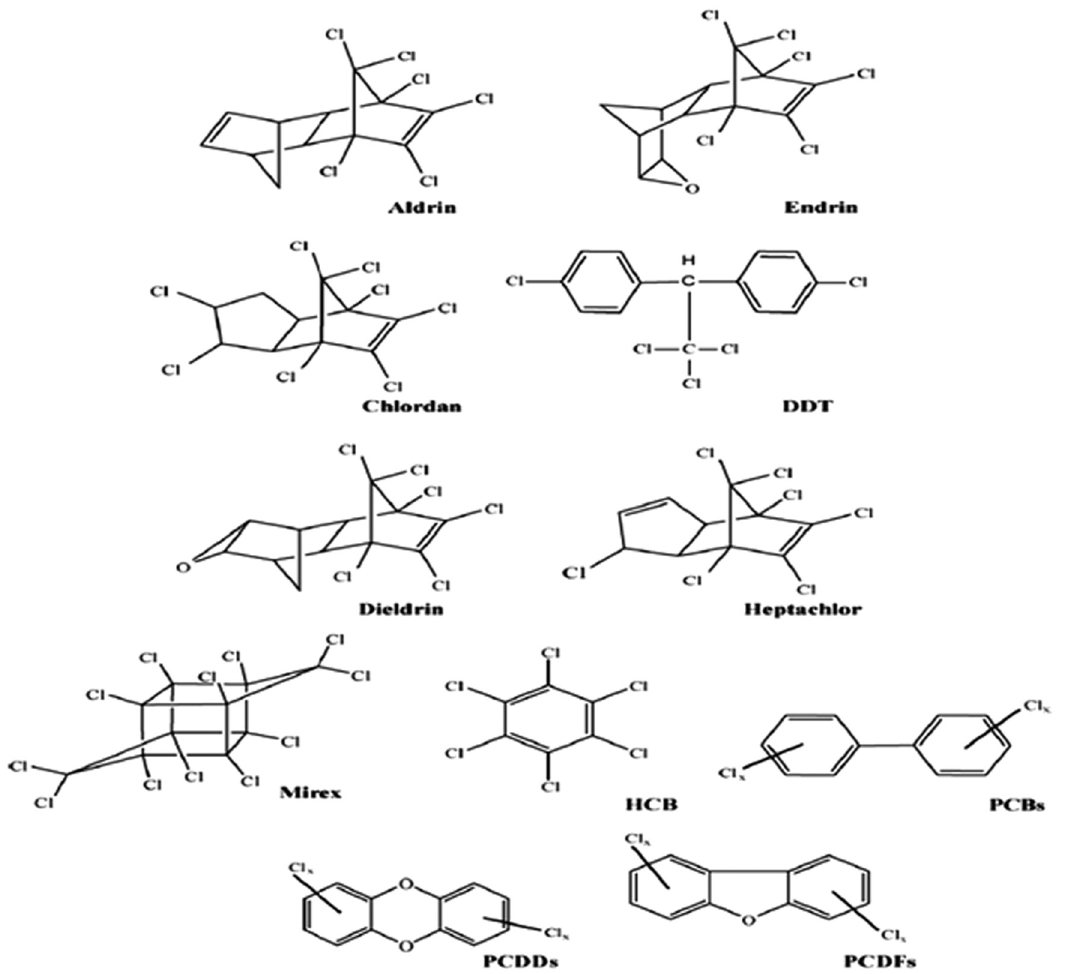
Figure 1: The chemical structure of most common persistent